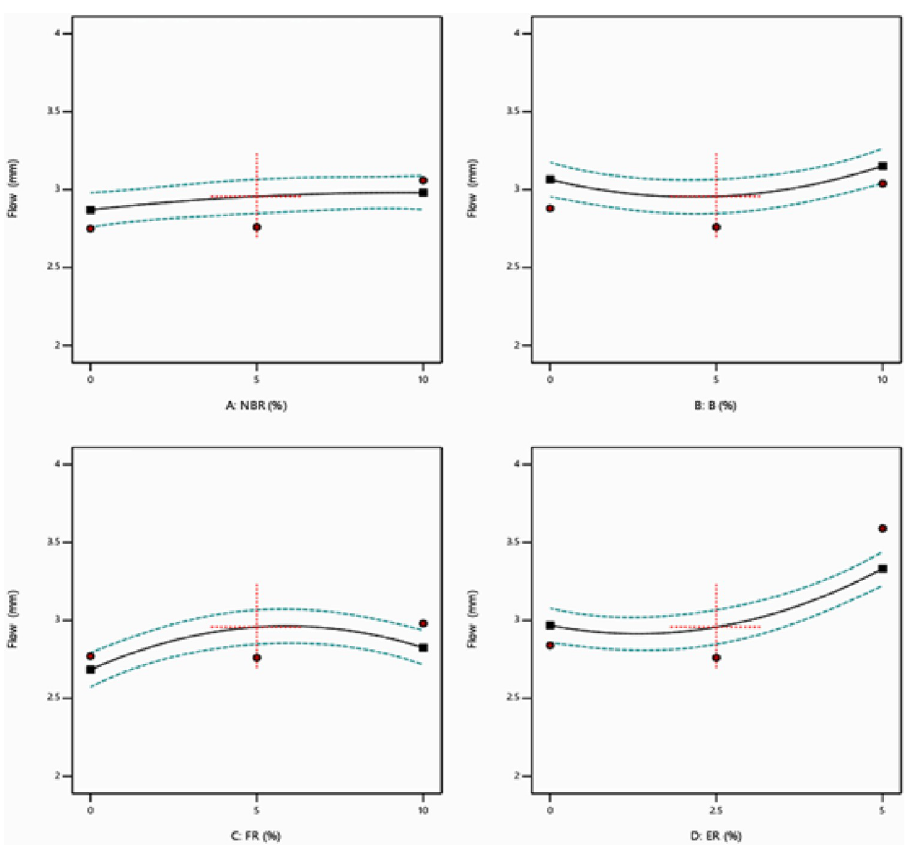
Fig 4. Individual effect plot for flow value.